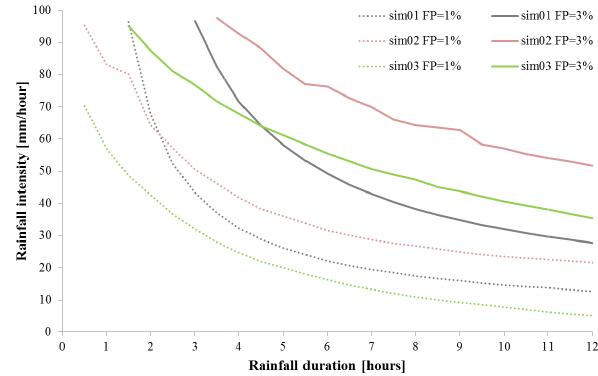
Figure 9. Comparison among CRT simulated with deterministic and spatially distributed soils parameters (sim01), deterministic homogeneous soils parameters (sim02), average values of the soils parameters equal to sim02 and PDF assigned (sim03).